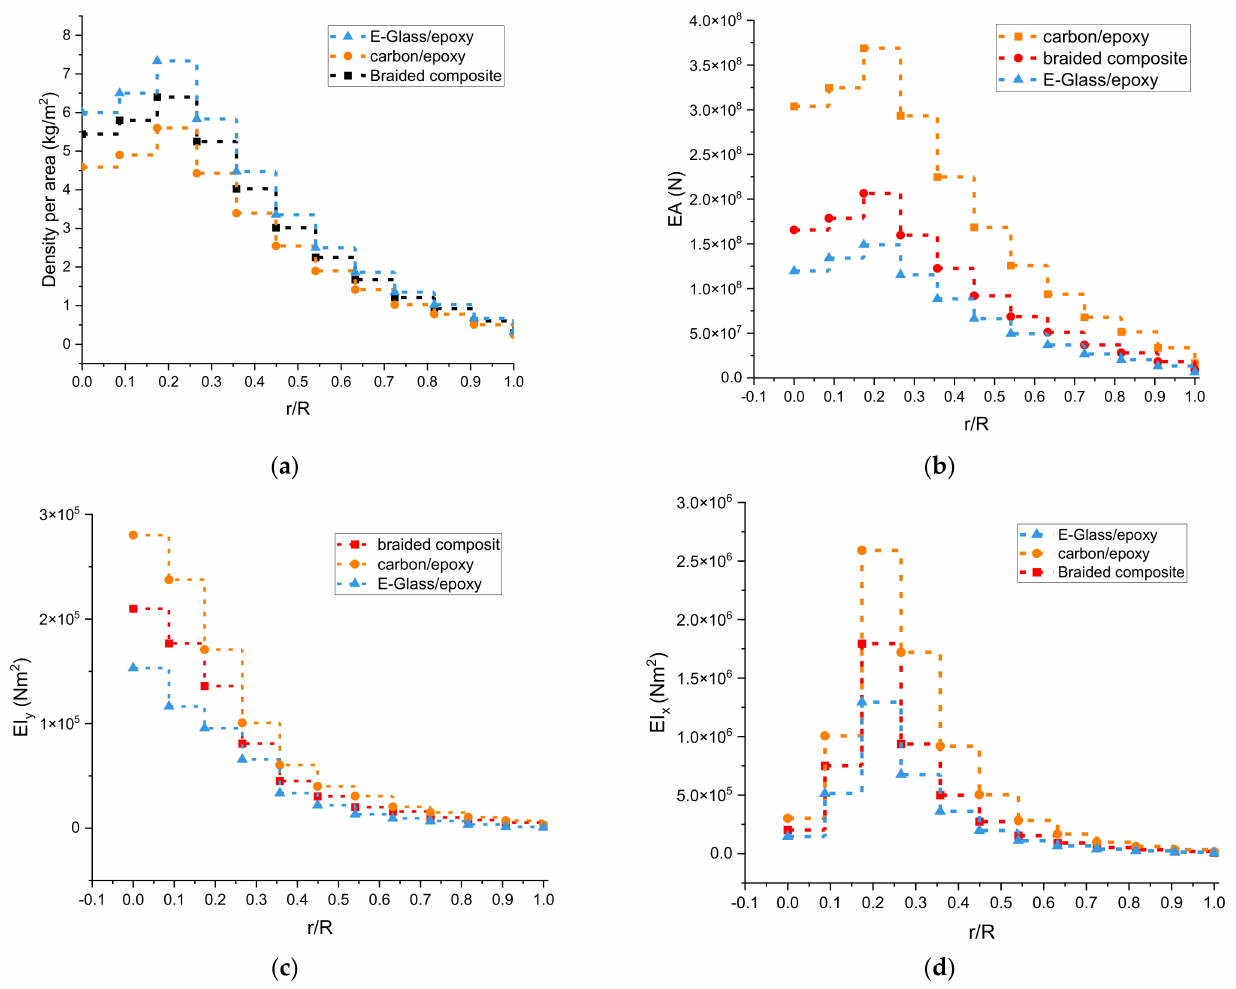
Figure 13. Distributions of ( a ) the density, ( b ) longitudinal stiffness, ( c ) Flapwise Stiffness, and ( d ) Edgewise Stiffness along the